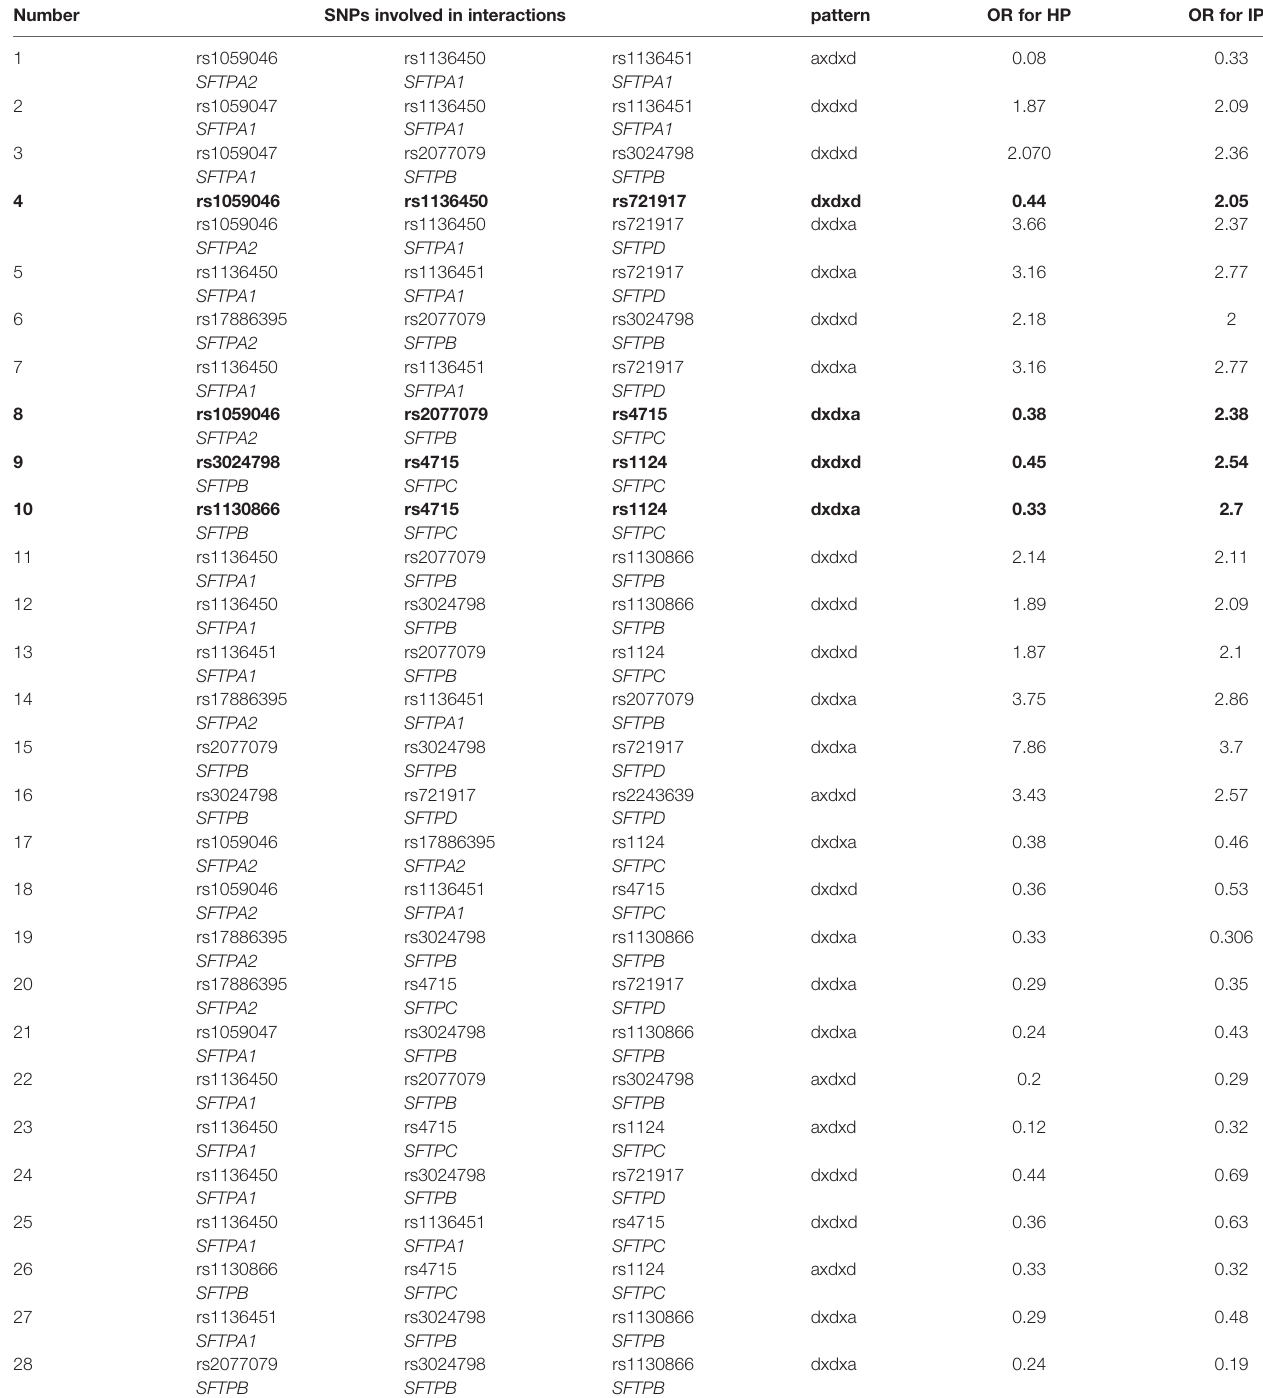
TABLE 7 | Interactions with the same SNPs and the same pattern effect in IPF and HP